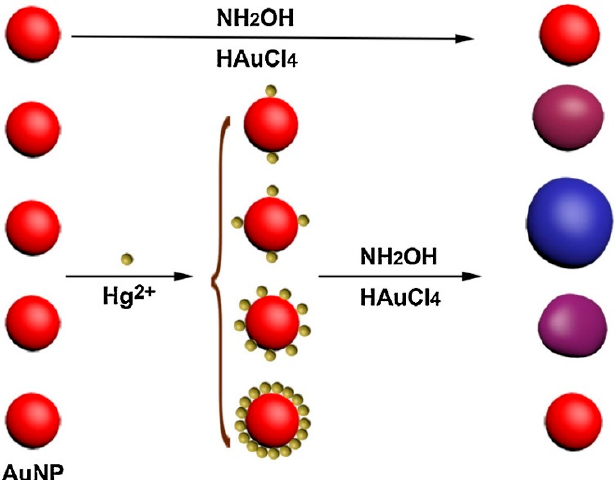
Figure 11. The schematic illustration of the amount of Hg on the surface of AuNP-controlled the growth of AuNPs. Reproduced with permission from Reference [118]. Elsevier B.V., 2017.